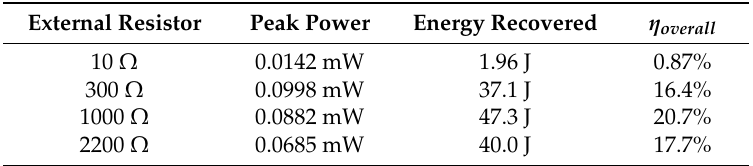
Figure 5. Simulated batch performance of MFC with 100 mg L − 1 initial substrate at different external resistors. ( A ) substrate concentration; ( B ) suspended biomass concentration; ( C ) external voltage; and ( D ) power generation. Table 3. Simulated peak power and energy recovery from an external resistor, and overall energy efficiency ( η overall ) at different external resistors.